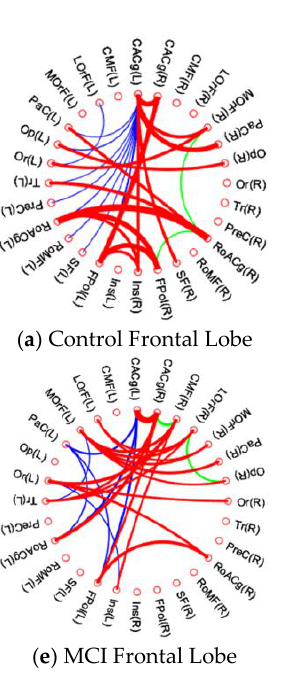
L/R/B, links in left hemisphere/ links in right hemisphere/ links between bilateral